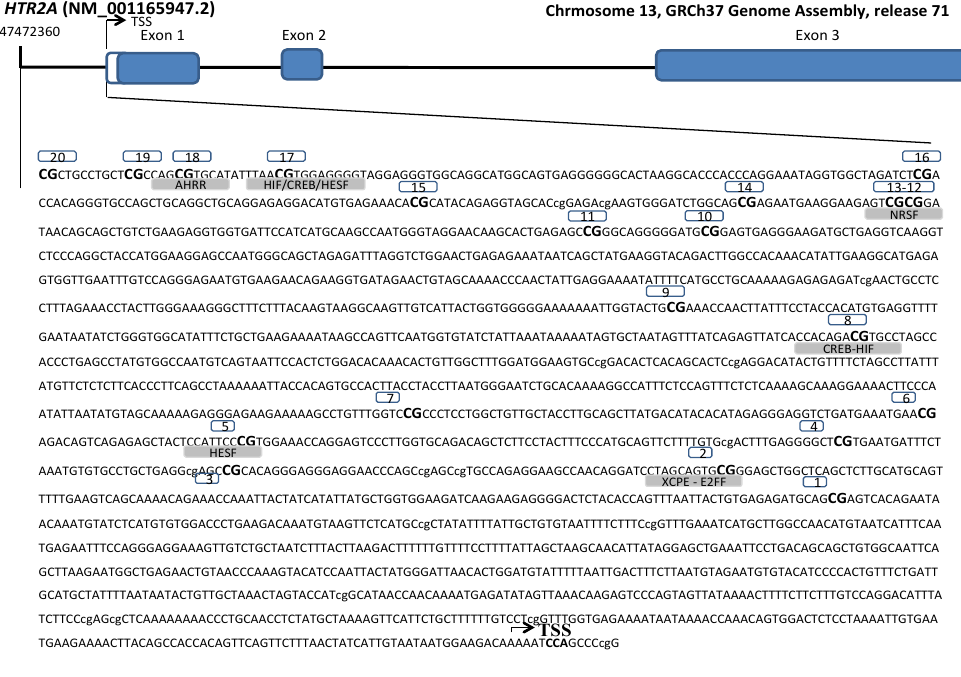
Figure 1. Genomic localization and nucleotide sequence of the 20 CpGs sites covered by the Illumina array for the study of DNA methylation levels of 5-hydroxytryptamine (serotonin) receptor 2A promoter (from − 2188 to +10 pb). Transcription Start Site (TSS). Putative consensus sequences for nine transcriptional factors (AHRR: AHR-related factors, HIF: Hypoxia inducible factor, CREB: cAMP-responsive element binding proteins, HESF: Vertebrate homologs of enhancer of split complex (Basic helix-loop-helix domain containing, class B, 2 (secondary DNA binding preference)), NRSF: Neuron-restrictive